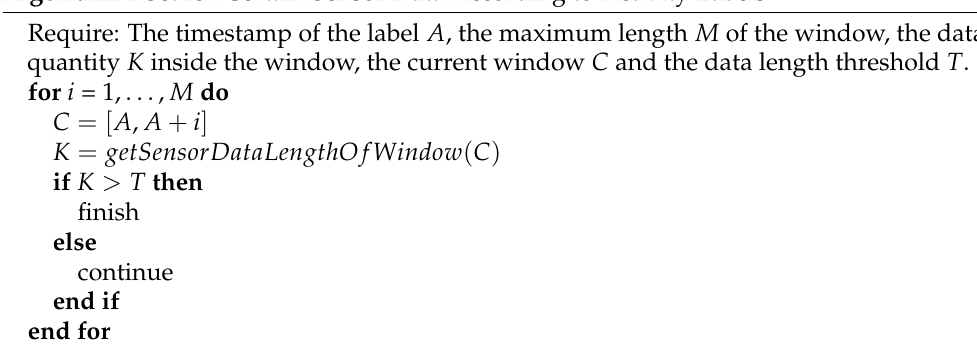
Algorithm 1 Search Certain Sensor Data According to Activity Labels